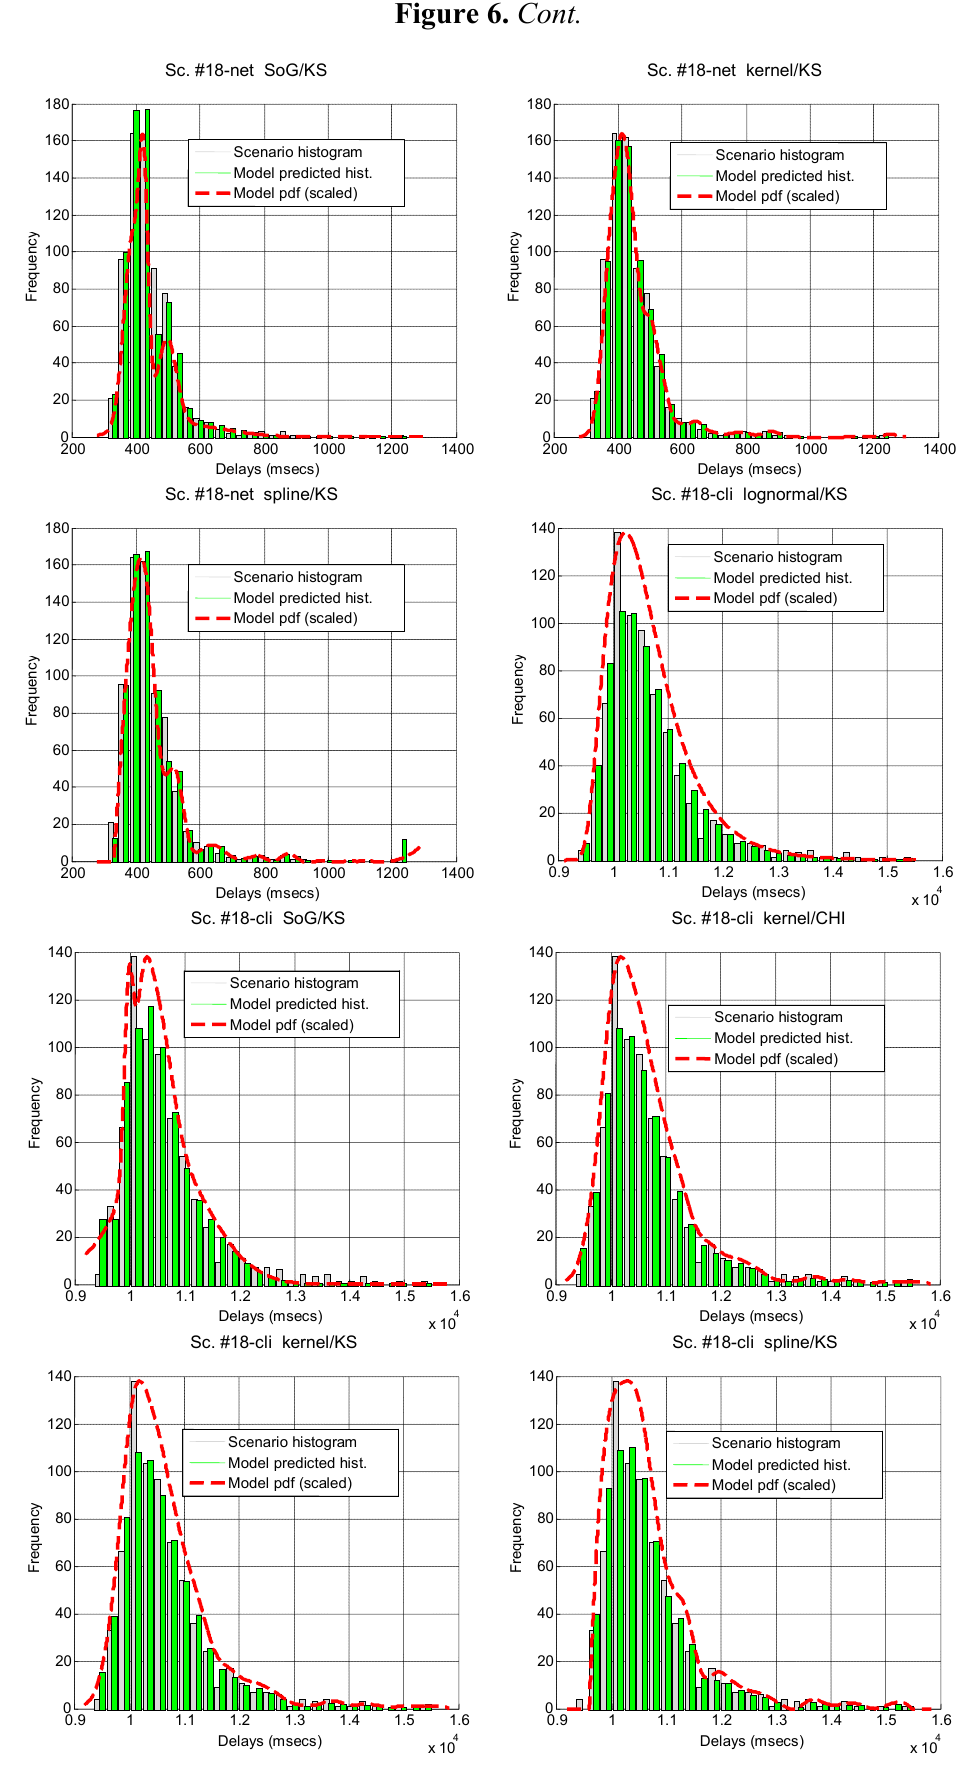
Scenario histogram Model predicted hist.